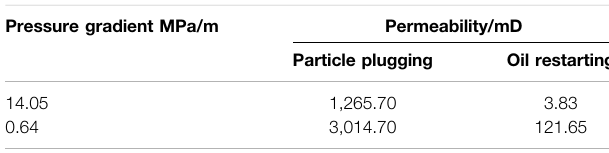
TABLE 4 | Comparison of plugging strength and oil restarting pressure.